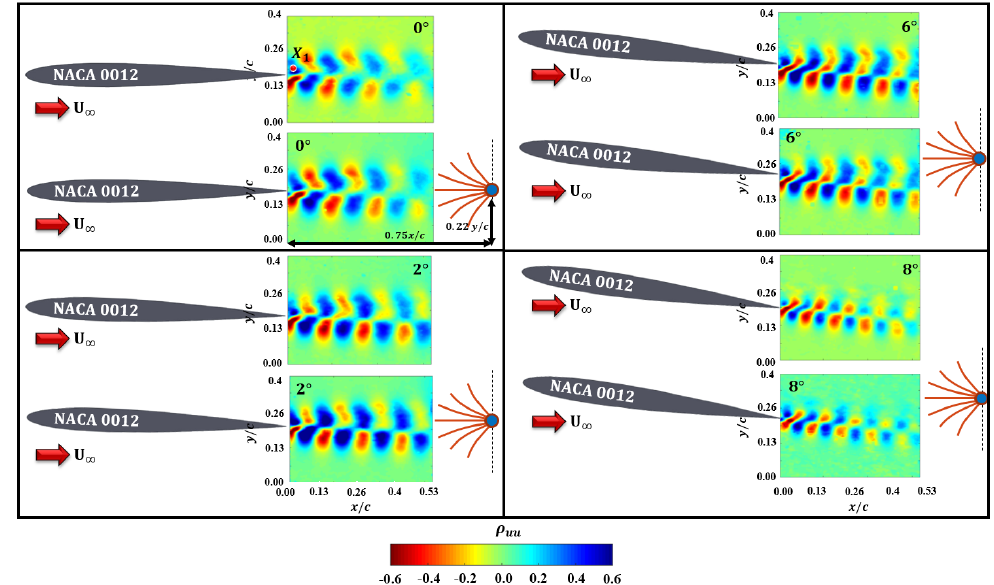
Figure 20. Two-point correlations of (streamwise fluctuating velocity component) in the wake of NACA 0012 with and without PVDF.